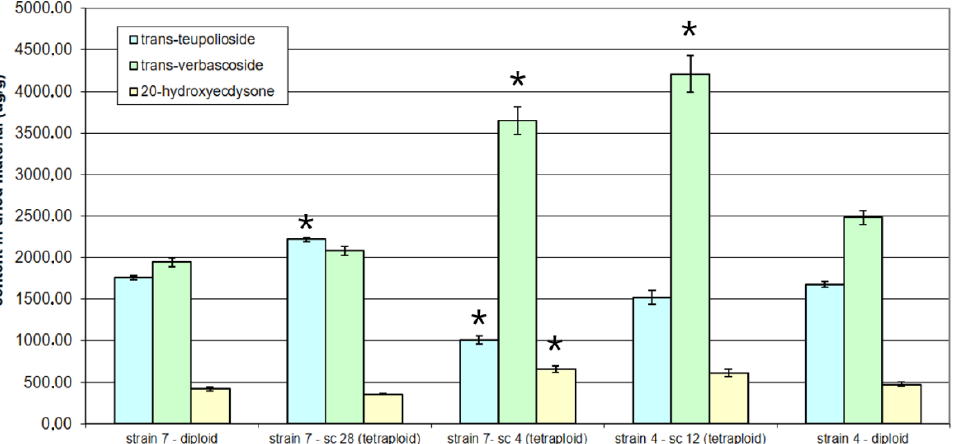
Figure 2. Contents of trans -teupolioside, trans -verbascoside and 20-hydroxyecdysone measured in dried shoots of two progenitor strains (7 and 4) and in tetraploid strains derived from those progenitors. Asterisks (*) mark significant differences of substance content in tetraploids in relation to diploid progenitors ( p value < 0.01).